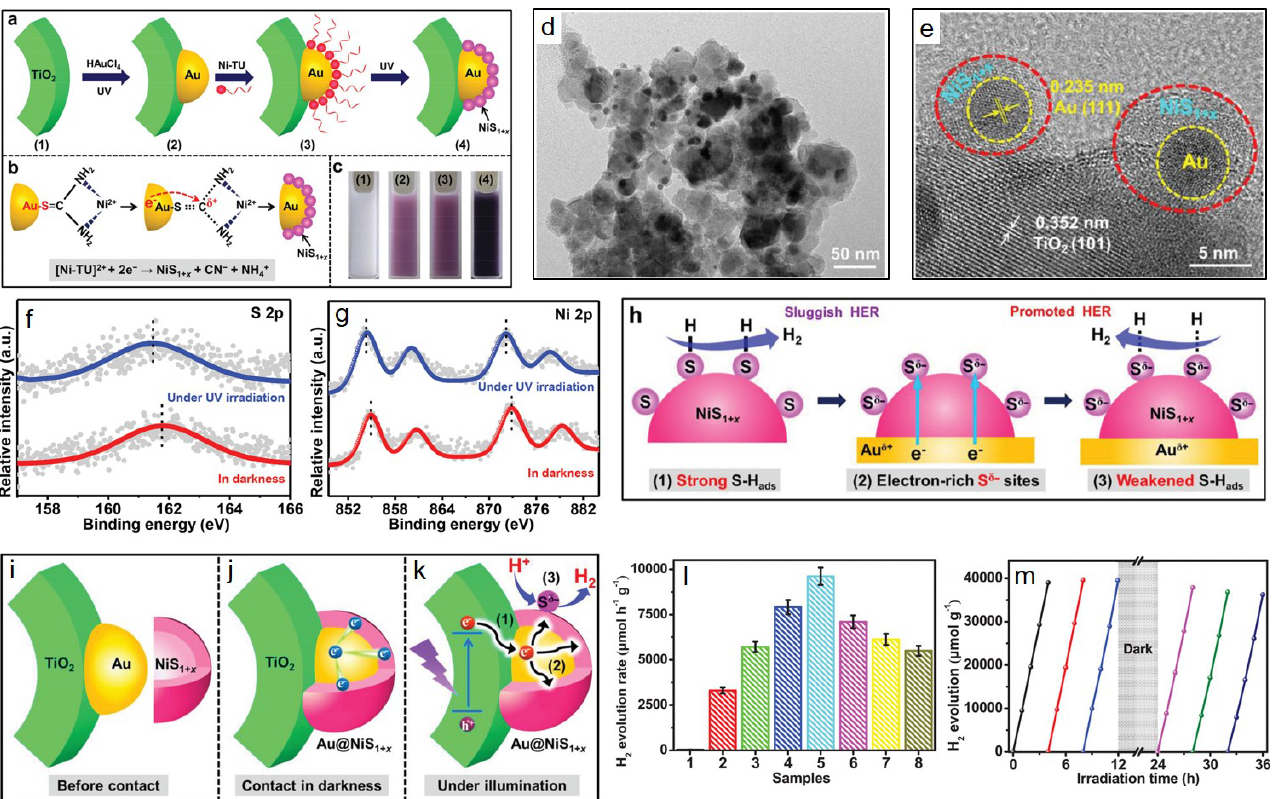
Figure 8. Schematic illustration of the synthesis procedure of the core-shell Au@NiS 1 + x combined TiO 2 photocatalyst ( a ) and the formation mechanism of NiS 1 + x on Au surface ( b ). ( c ) shows the corresponding photographs for (1) TiO 2 , (2) TiO 2 /Au, (3) TiO 2 /Au@Ni-TU (TU stands for thiourea), and (4) TiO 2 /Au@NiS 1 + x . ( d ) TEM and ( e ) HRTEM images of the TiO 2 /Au@NiS 1 + x